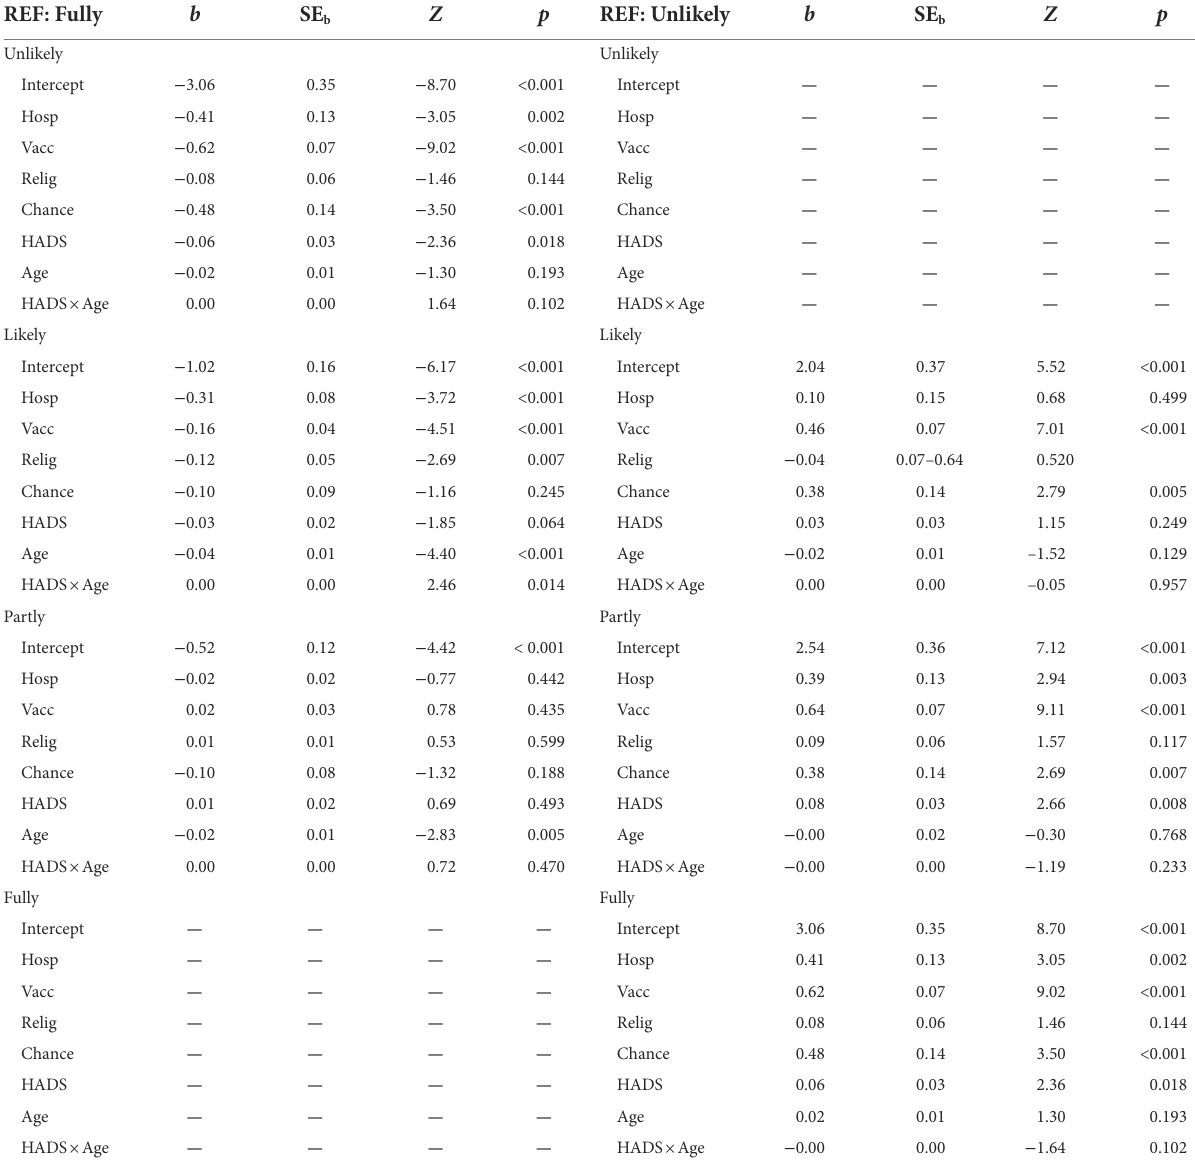
TABLE 7 Multinomial analysis of groups differing in vaccination status with fully vaccinated and unlikely to get vaccinated as reference (REF)